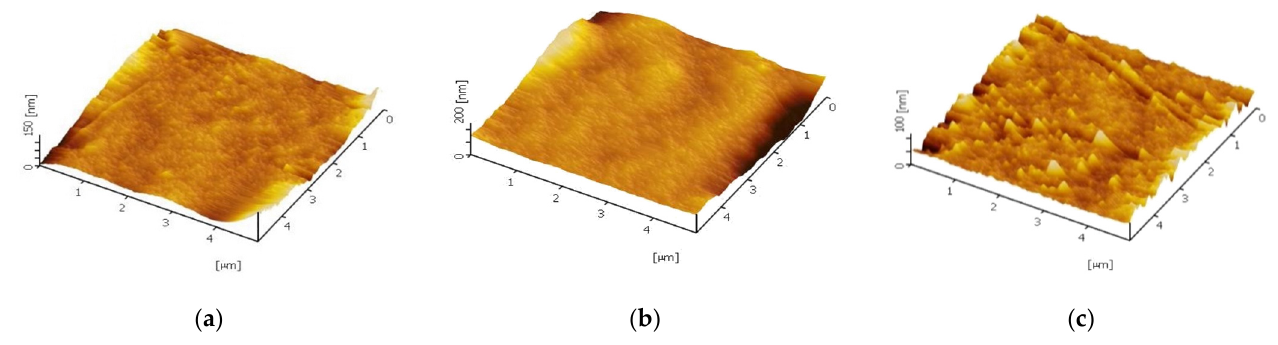
Figure 4. Three-dimensional AFM images for ( a ) Blank PES, ( b ) M3, and ( c ) M4. Table 6. AFM surface roughness values of the neat and hybrid membranes.